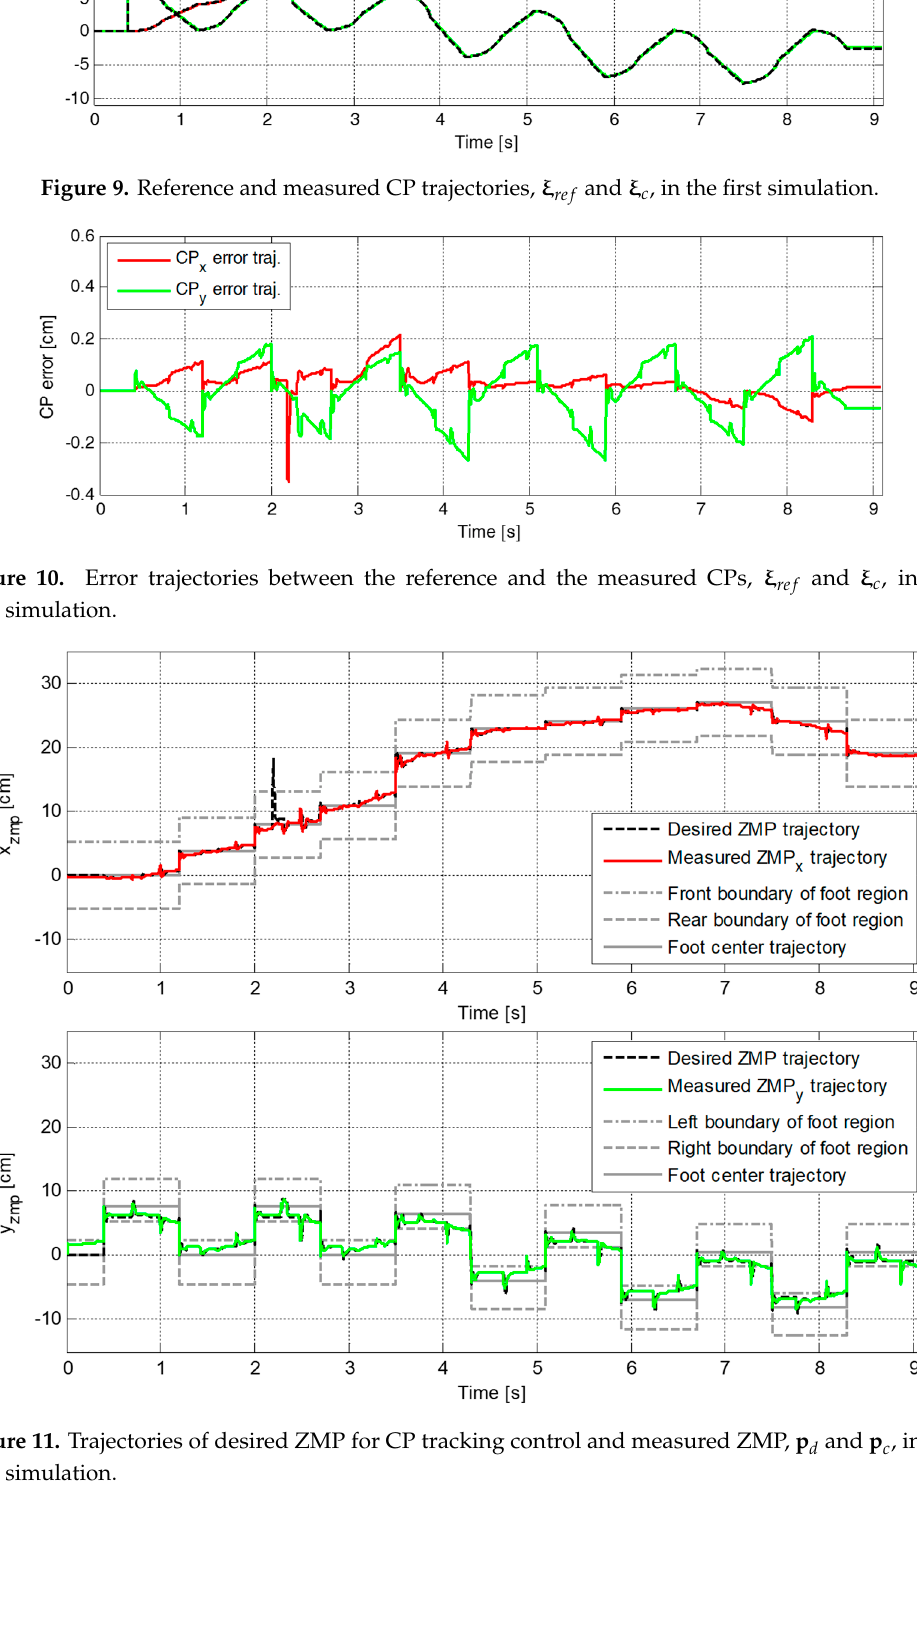
p d and c , in the